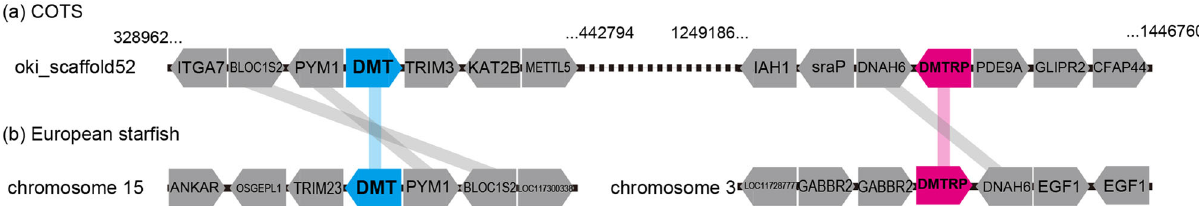
Fig. 3 Genes around divalent metal transporter (DMT) and DMT-related protein (DMTRP) genes. a The crown-of-thorns star fi sh (COTS), Acanthaster planci and b the European star fi sh, Asterias rubens . Scaffold names and chromosome numbers are indicated on the left. Genes and their orientations are indicated by pentagons of the same size. DMT, DMTRP, and other genes are indicated in blue, magenta, and gray. Numbers above the COTS scaffold indicate start or end positions of gene locations. Protein names and gene IDs are listed in Table